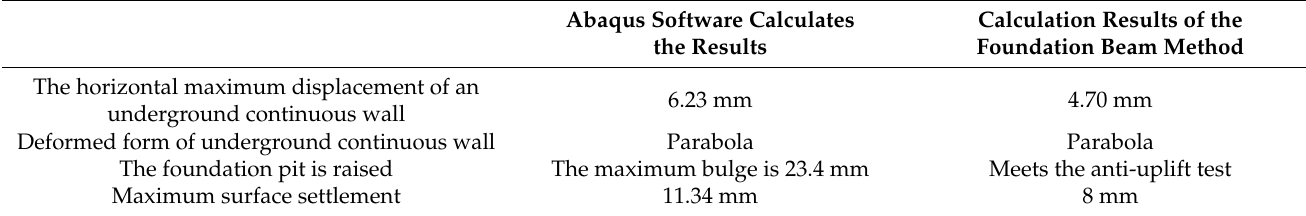
Table 1. Numerical simulation compared with foundation beam method calculation results.